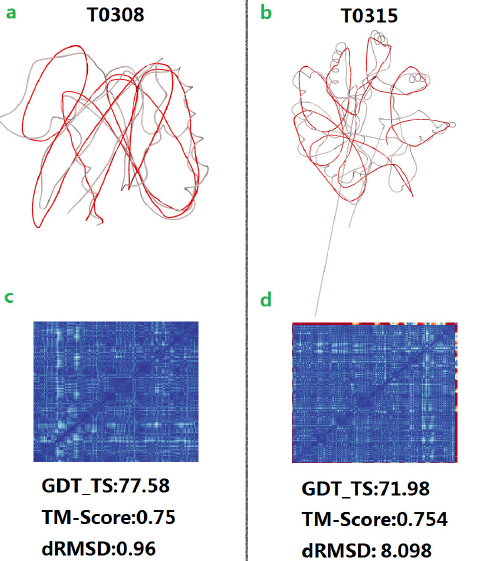
Figure 13. Comparison of the similarity of two proteins, T0308 and T0315. ( a , b ) show the visualization of the tertiary structure after alignment. Red is the predicted structure, gray is the real structure. Charts ( c , d ) show the visualization of the distance matrix of the two